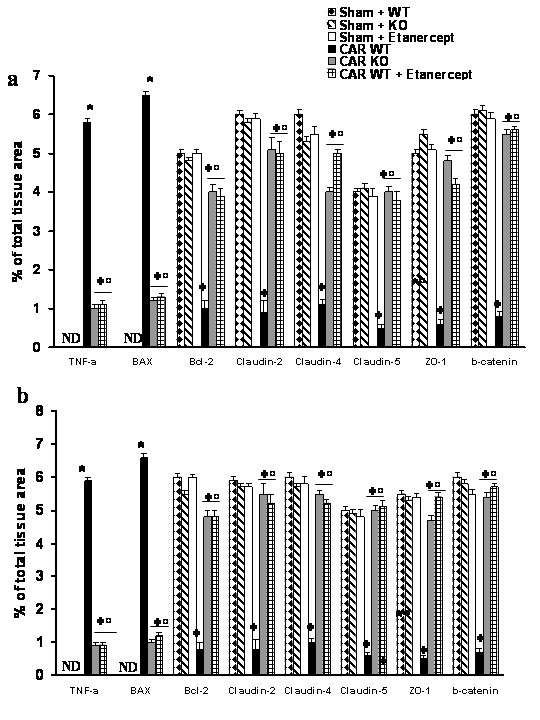
Typical Densitometry evaluation. Densitometry analysis of immunocytochemistry photographs (n = 5 photos from each sample collected from all mice in each experimental group) for TNF-α, Bax, Bcl-2 Claudin-2, Claudin-4, Claudin-5, ZO-I and β-catenin from lung tissues was assessed. The assay was carried out by using Imaging Densitometer (AxioVision, Zeiss, Milan, Italy) on a personal computer. Data are expressed as % of total tissue area. *P < 0.01 vs. SHAM; °P<0.01 vs. carrageenan- WT group ND: not detectable.